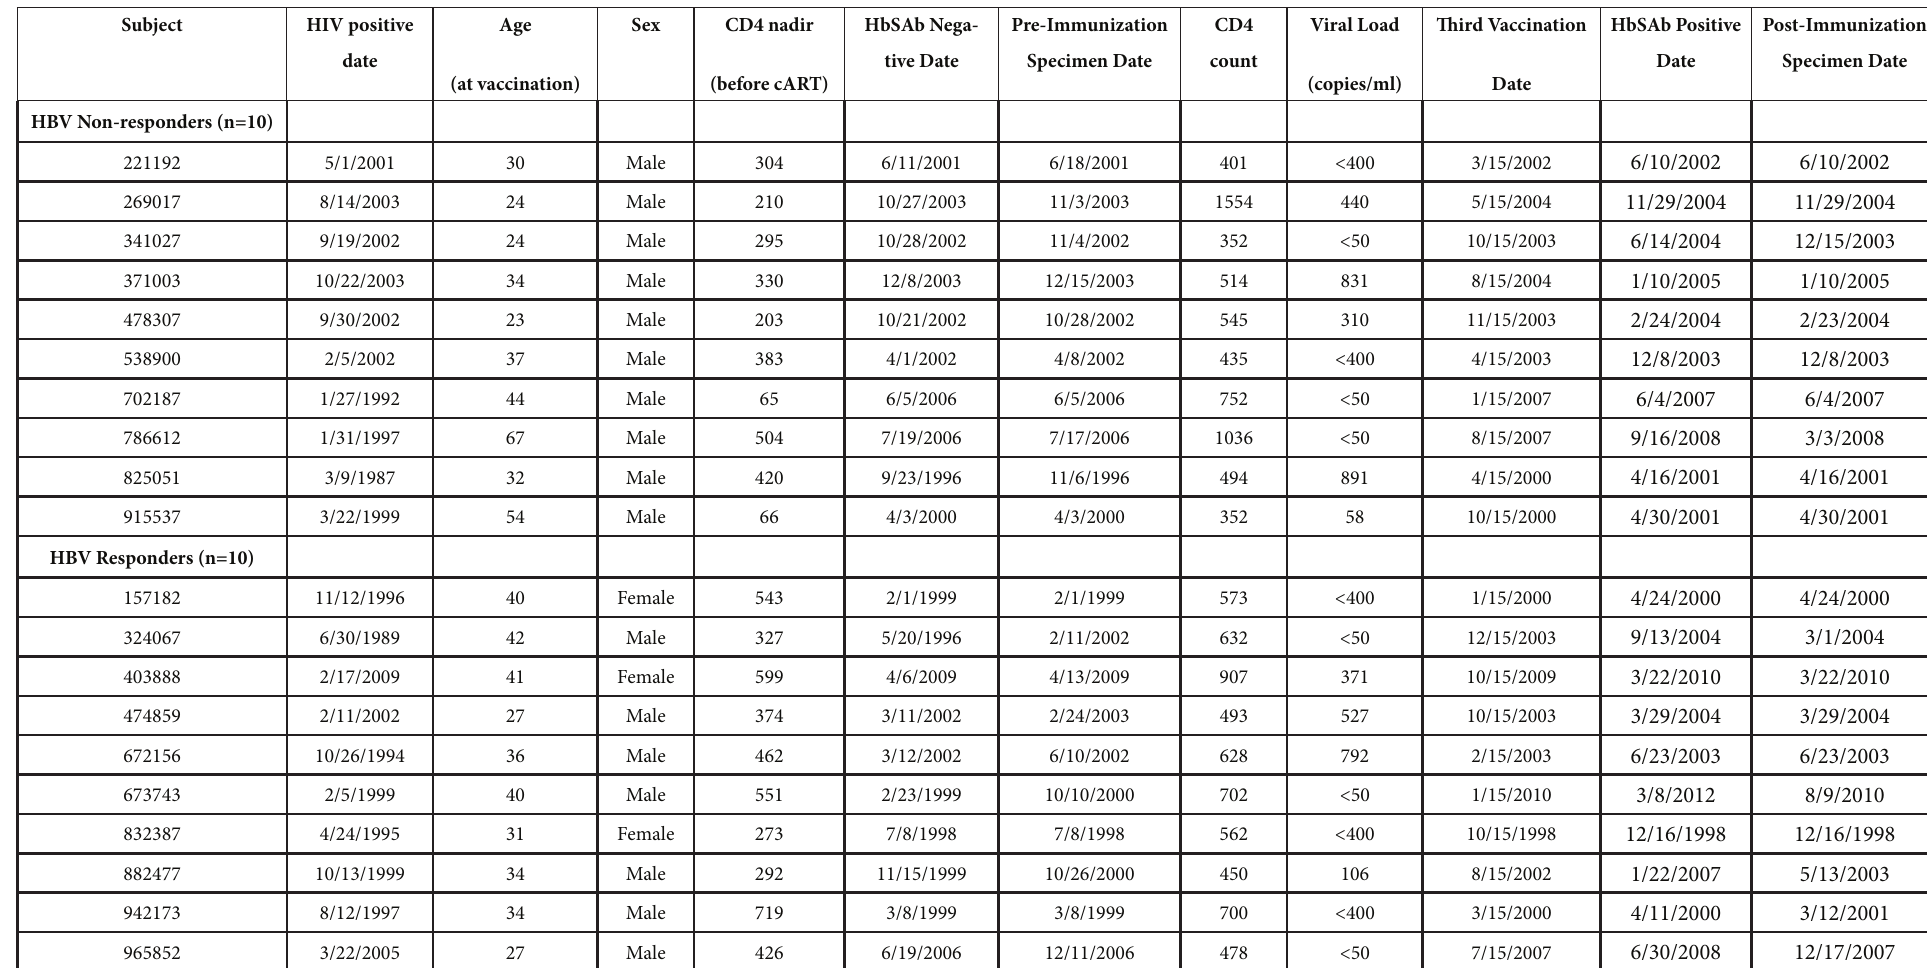
Supplementary Table. Characteristics of vaccine cohort